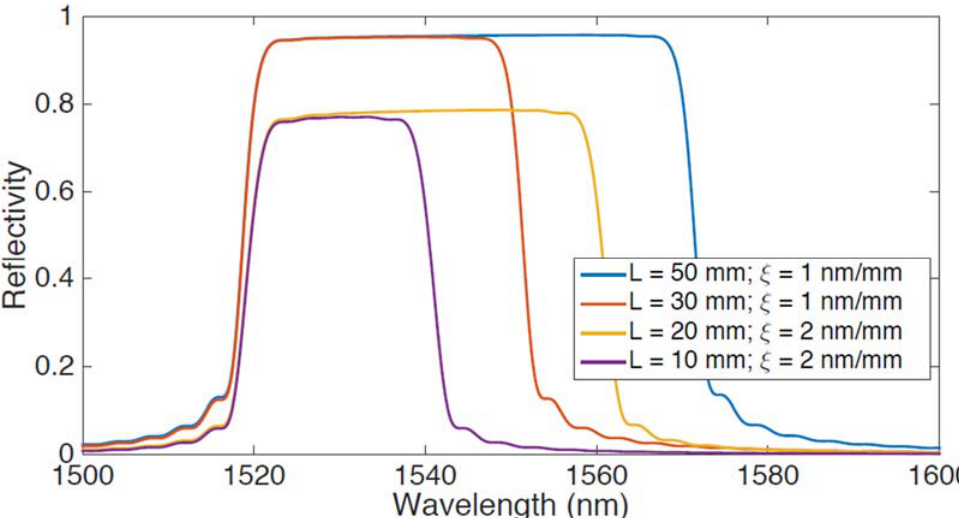
Figure 2. Simulation of CFBG spectra using the CMT ‐ based model. The chart shows spectra having different length L ranging between 20 mm and 50 mm, and chirp rate coefficient ξ equal to 1–2 nm/mm; the other grating parameters are δ n eff = 10 − 6 , n eff = 1.5, λ B (0) = 1520 nm, kL g = 0.4 and the discretization step is L g = 0.2 mm.